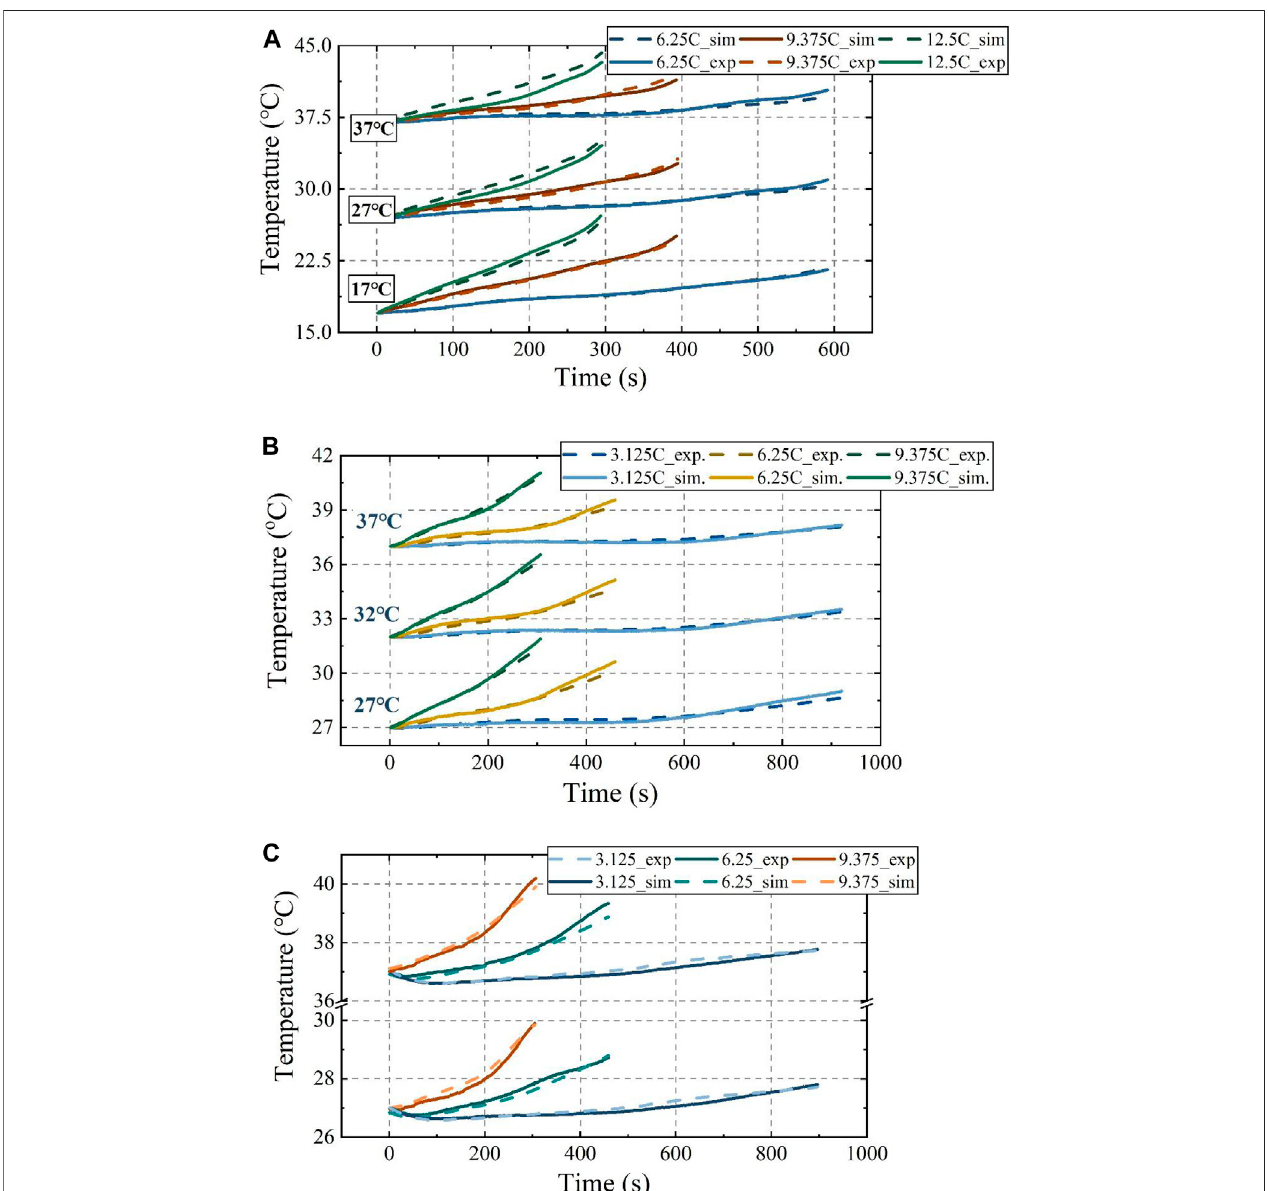
FIGURE4| Thermalmodelvalidationatdifferentcurrentsandambienttemperatures: (A) Cellthermalmodel; (B) Batterypackthermalmodel; (C) BTMSthermalmodel.